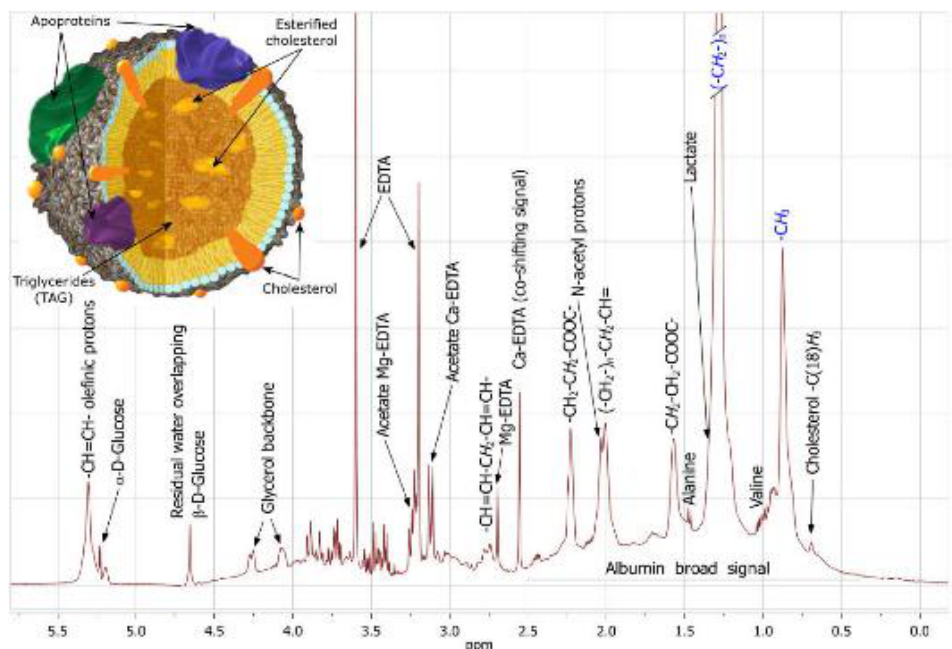
Figure 41. Representative 1 H-NMR spectrum (500 MHz) of human blood. Inset shows a schematic view of the micellar chylomicron structure. Adopted, with permission, from [202]. Copyright 2010, BioMed Central Ltd.